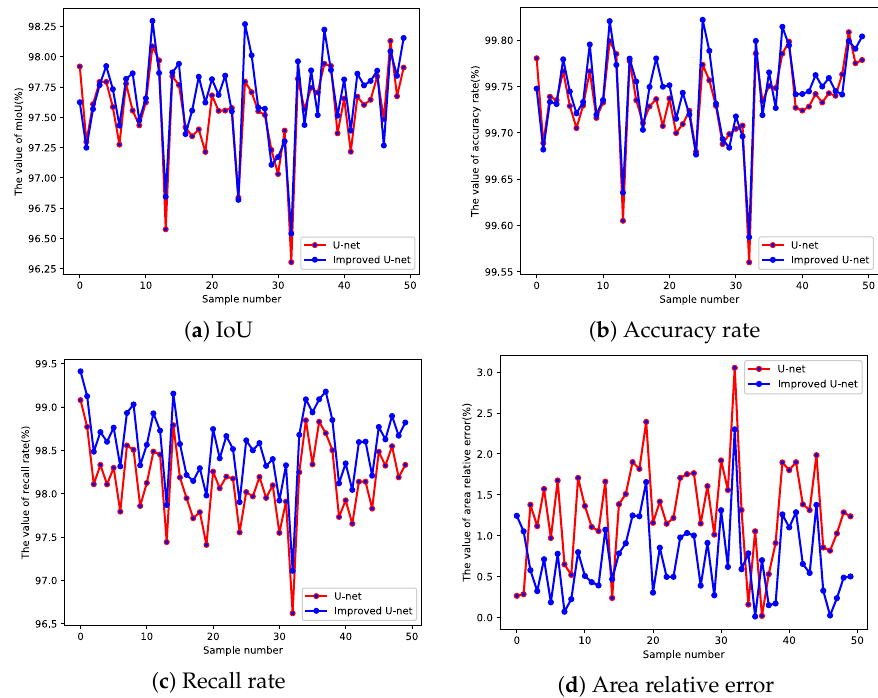
Figure 14. Comparison of performance on four metrics when the fish body is not tilted.